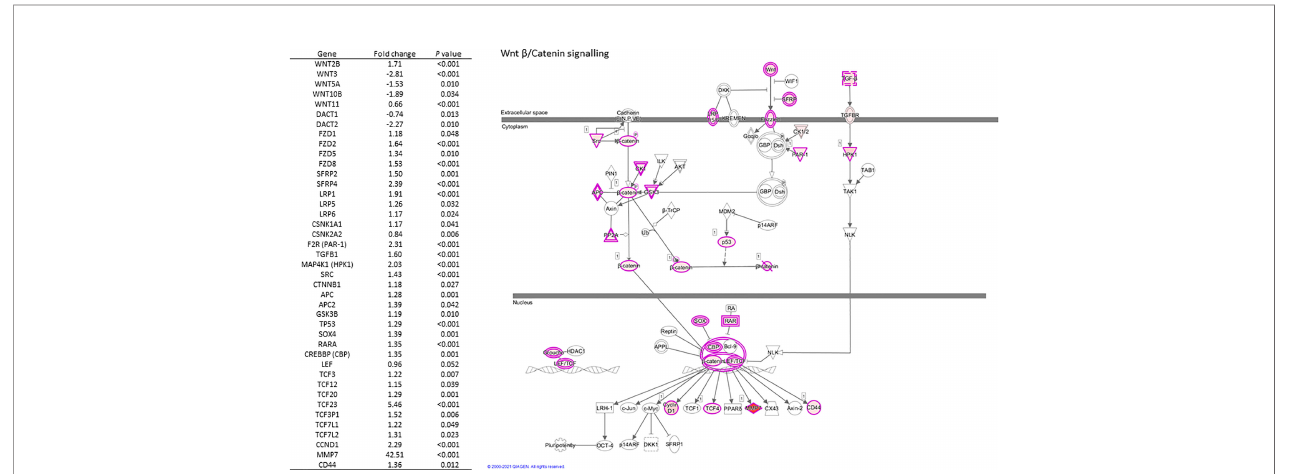
FIGURE 4 | Regulation of scWATWnt/ b -Catenin signalling and differential expression of pathway genes in individuals living with obesity at week-0.